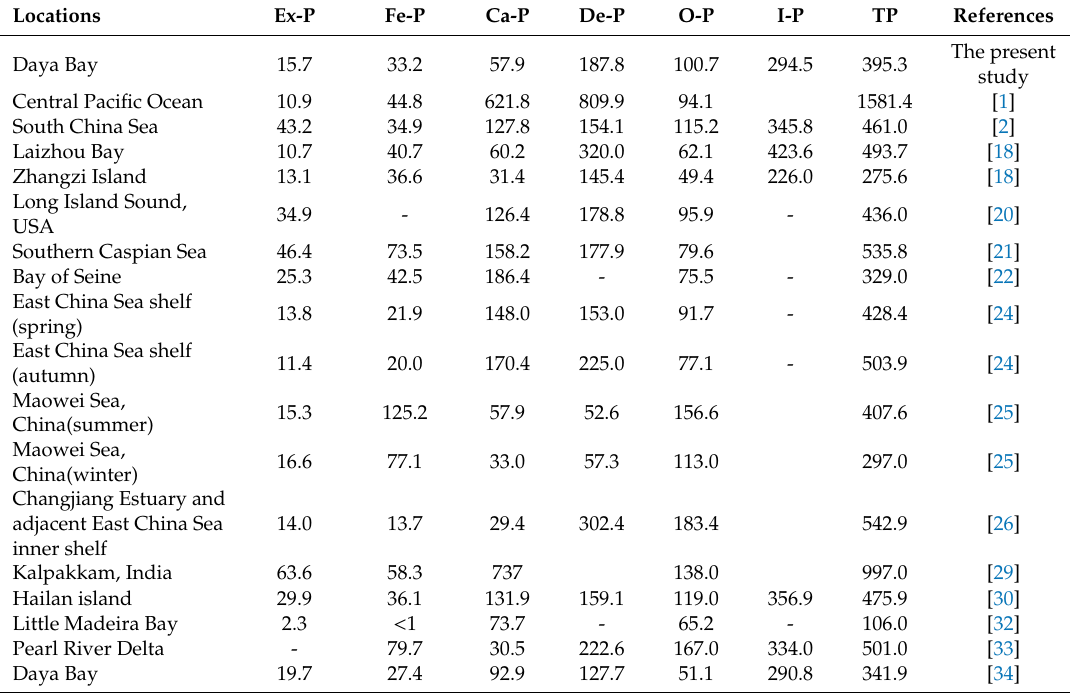
Table 4. The average concentration of di ff erent P forms in surface sediments determined in this study compared with measurements from other estuaries and coastal seas ( µ g /